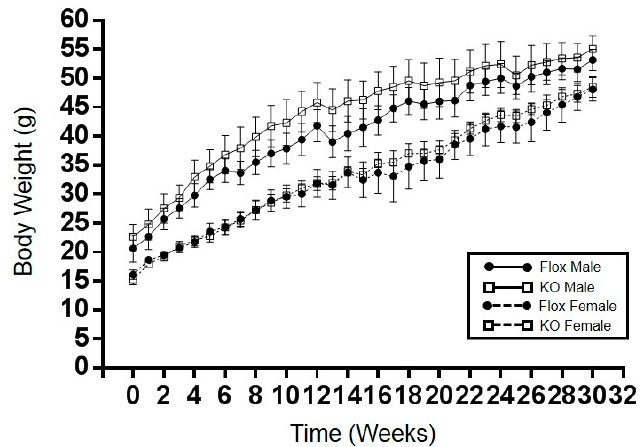
Figure 1. Weekly body weights of male and female Flox and KO (knockout) mice placed on a high-fat diet. No significant effect of on body weight was detected between males and females. Flox males, n = 8, KO males, n = 7, Flox and KO females, n = 6.